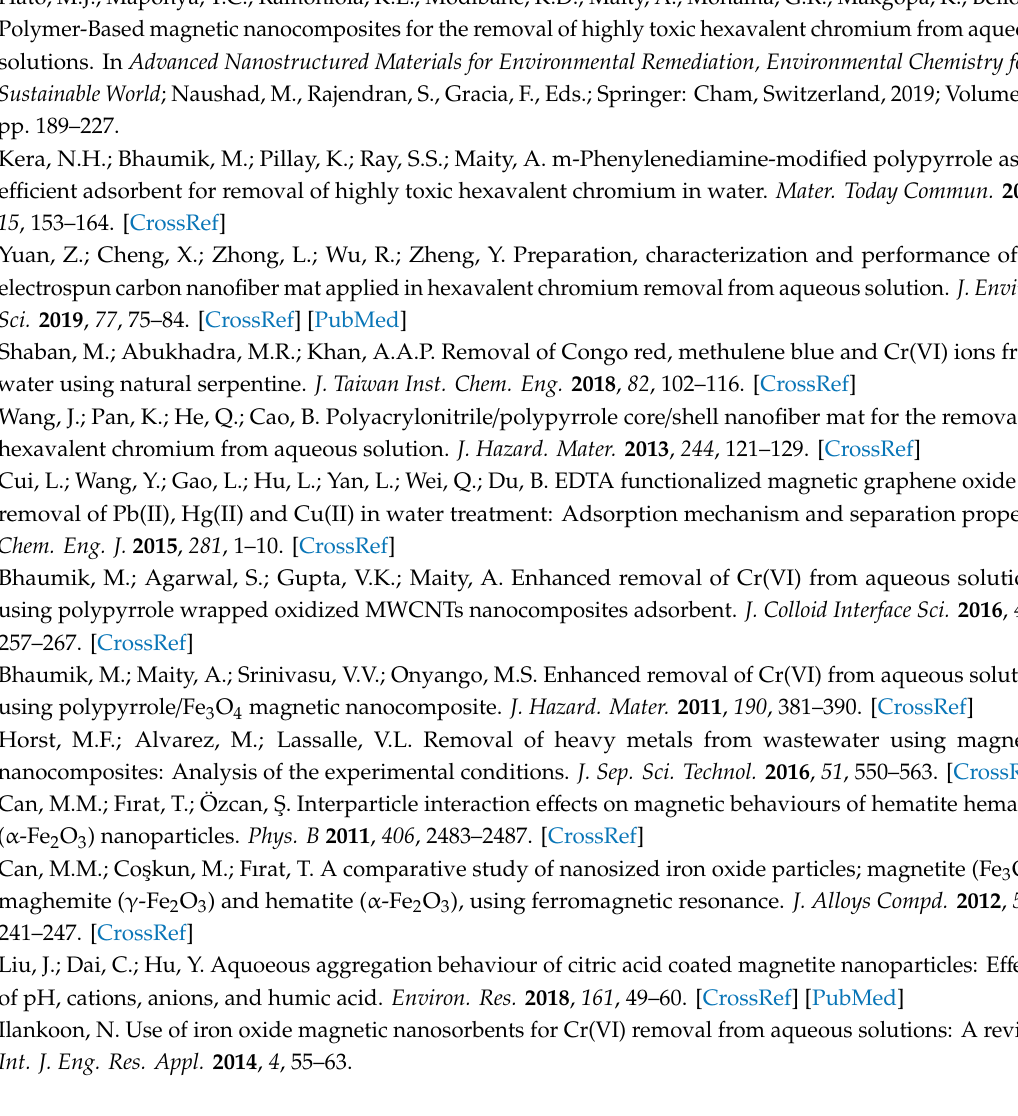
Figure S4: Linear fit of pseudo second order kinetic model for Cr(VI) adsorption by the PPy- m PD / Fe 3 O 4 nanocomposite, Figure S5: Plots obtained for the intra-particle di ff usion (IPD) model for Cr(VI) adsorption by the PPy– m PD / Fe 3 O 4 nanocomposite, Table S1: Adsorption capacity of the PPy– m PD / Fe 3 O 4 nanocomposite adsorbent, studied in comparison to other adsorbents reported in the literature for the removal of Cr(VI) from solution, Table S2: Thermodynamic values for Cr(VI) adsorption by the PPy– m PD / Fe 3 O 4 nanocomposite, Table S3: Kinetics parameters of Cr(VI) adsorption by the PPy– m PD / Fe 3 O 4 nanocomposite, Table S4: Intra-particle di ff usion